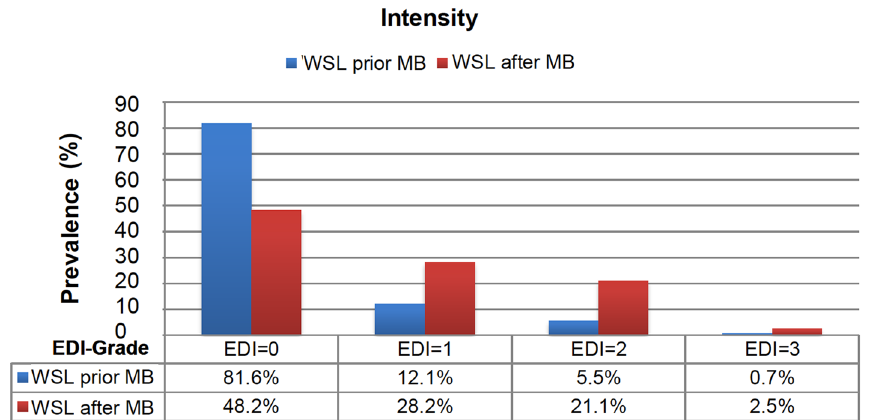
Figure 4. Bar diagram describing the WSL prevalence distributed by percentage of intensity (with Enamel Decalicification Index, EDI). The x-axis shows EDI levels 0–3 and their percentage of the WSL evaluation prior to and after MB. The y-axis specifies the prevalence in